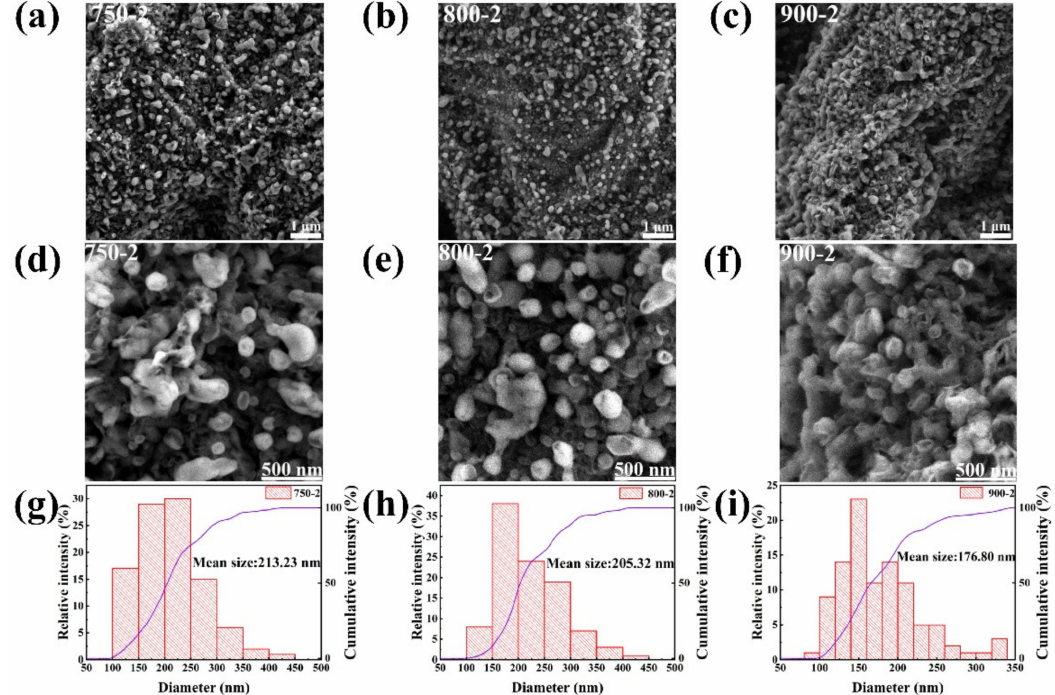
Figure 4. ( a , d ) SEM images of 750-2; ( b , e ) SEM images of 800-2; ( c , f ) SEM images of 900-2; ( g – i ) Parti- cle size distribution of 750-2, 800-2,